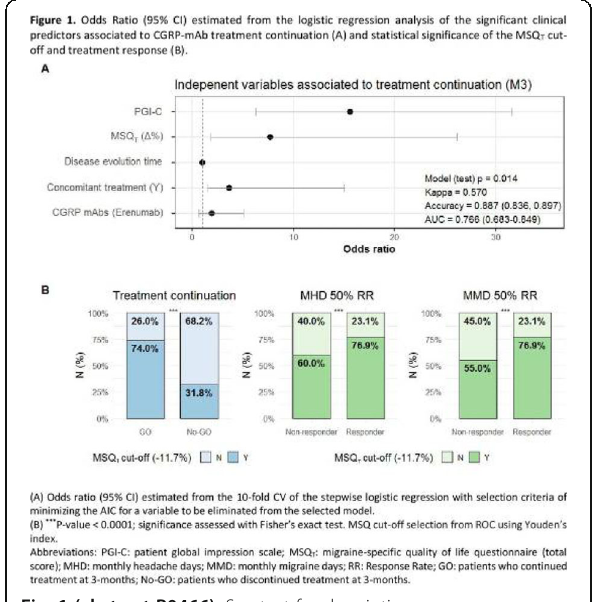
Fig. 1 (abstract P0465). See text for description